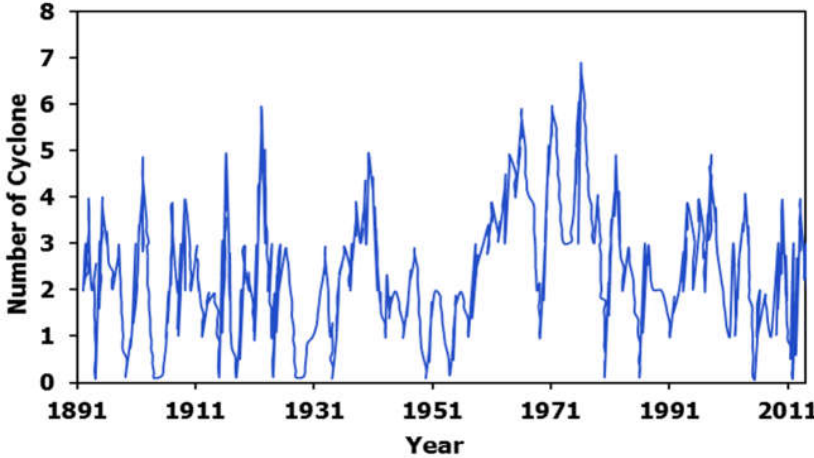
Figure 3. Frequency of very severe cyclones (1891–2011).